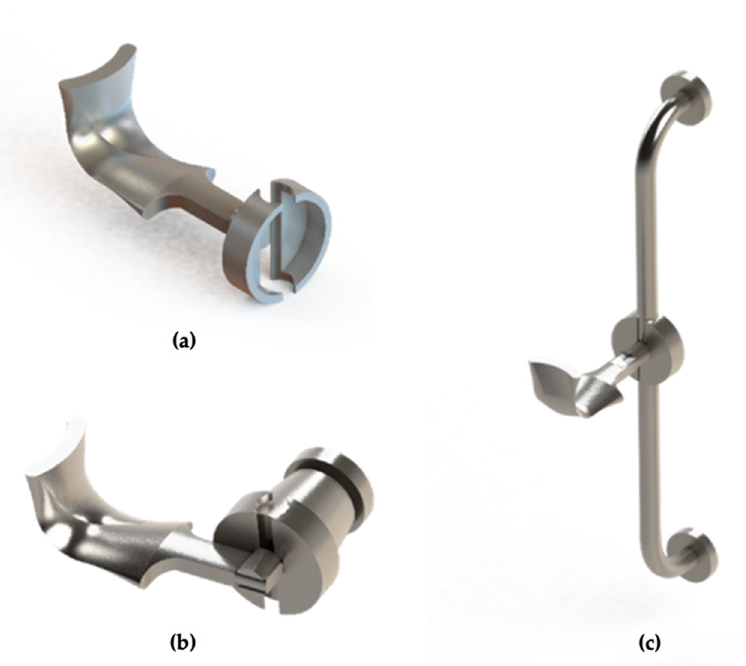
Figure 2. Auxiliary Door Opening Device—ADOD-V1: ( a ) 3D model; ( b ) representation of system coupled to a cylindrical handle; ( c ) representation of the system coupled to a D type handle.